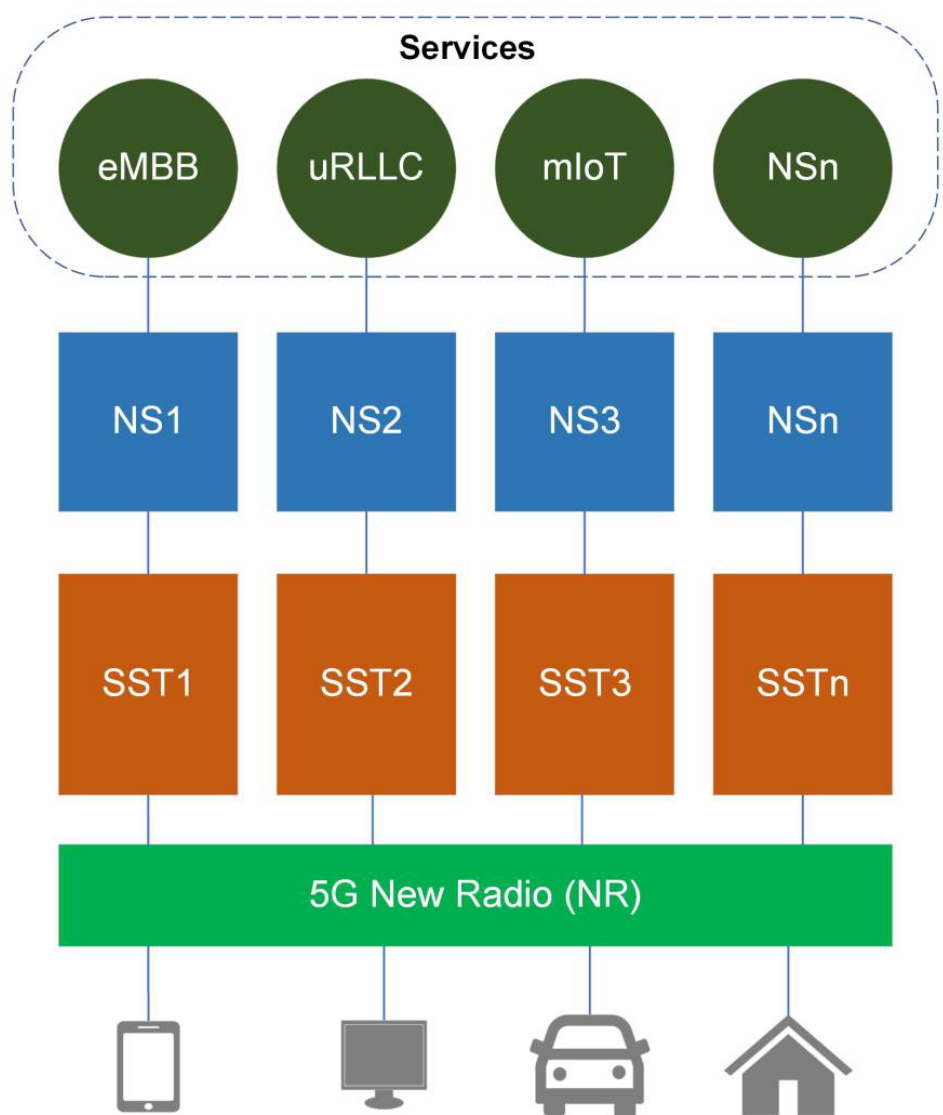
Figure 2. The 5G framework for NS based on SST.